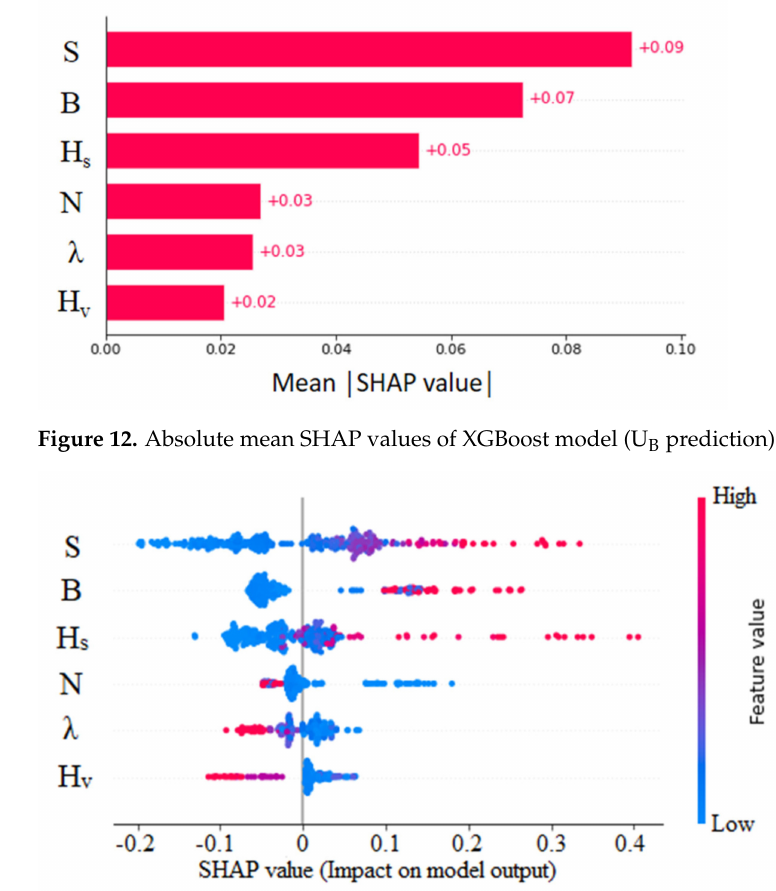
Figure 13. SHAP values of XGBoost model (U B